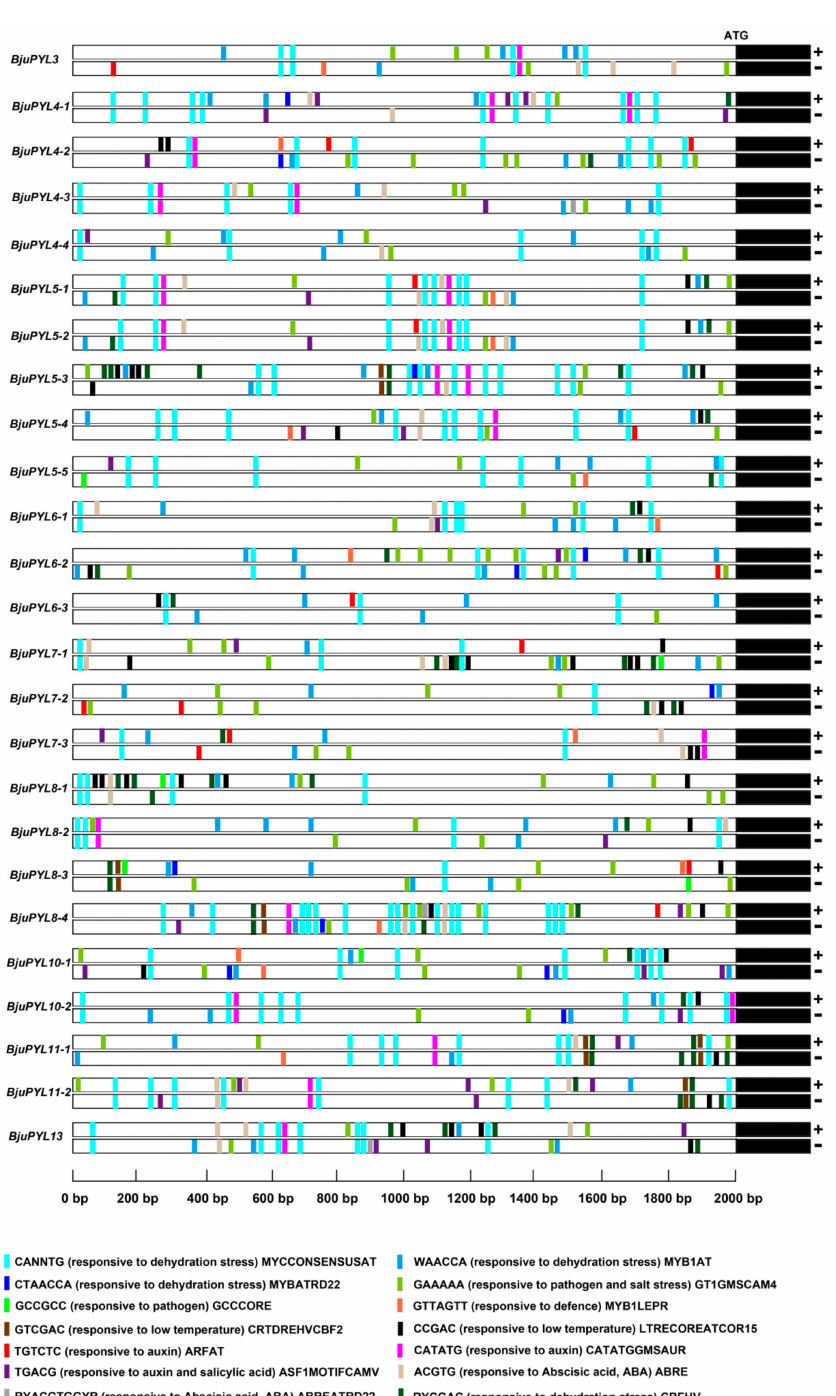
Figure 4. The promoter cis -elements analysis of BjuPYLs . The 2 kb DNA fragments upstream of the ATG staring code of BjuPYLs were analyzed using online analysis software PlantCARE (http: // bioinformatics.psb.ugent.be / webtools / plantcare / html / ) and PLACE (https: // sogo.dna.a ff rc.go.jp / cgi-bin / sogo.cgi?lang = en&pj = 640&action = page&page =